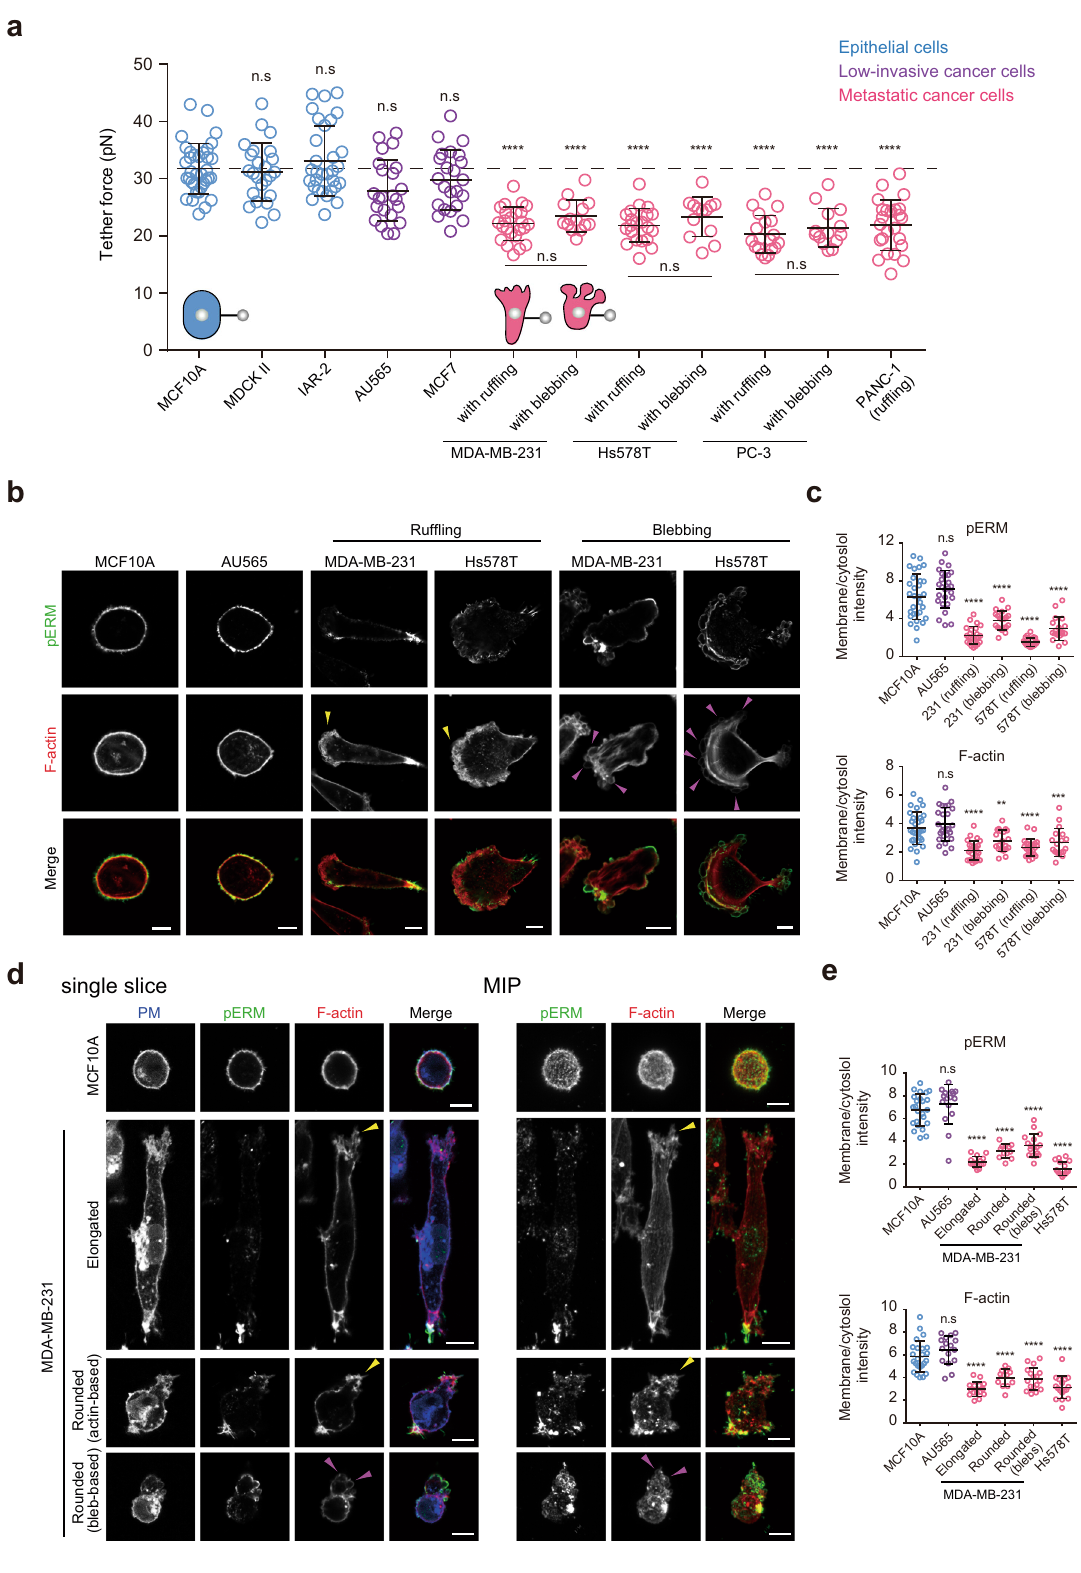
(Supplementary Fig. 2b), which corresponded to a decrease in PM tension (Fig. 2a). Of note, phosphorylated myosin light chain (pS19MLC), a marker for myosin II activation, was not affected in ERM and SLK + STK10 depleted cells (Supplementary Fig. 2c), indicating that the observed differences in PM tension were speci fi cally due to changes in MCA rather than those